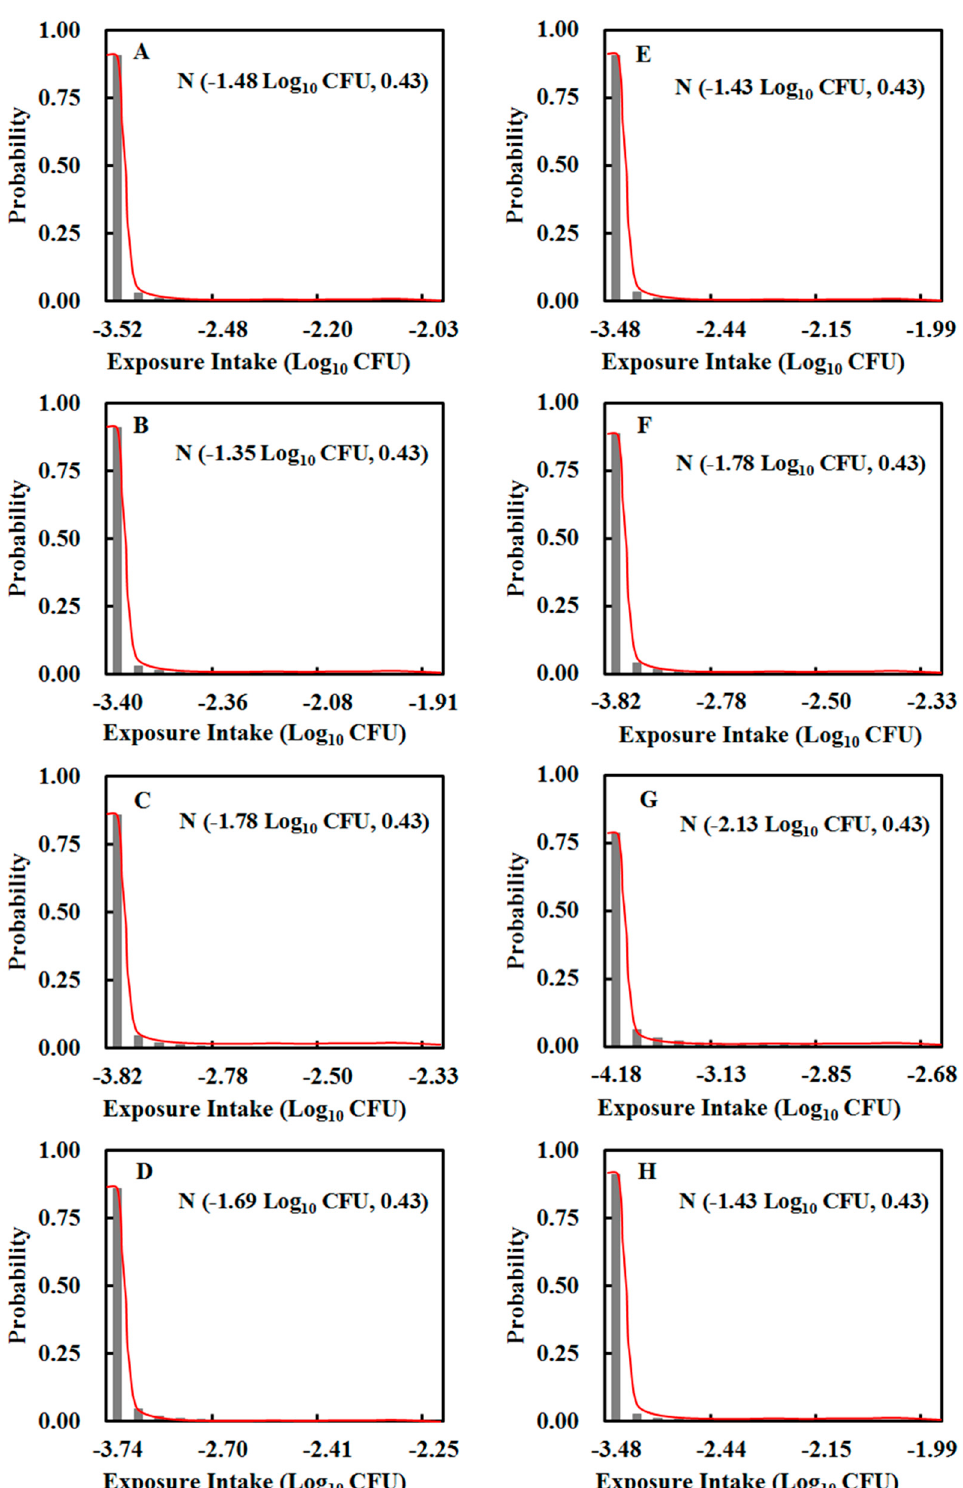
Figure A2. The probability distribution of ingesting E. coli O157:H7 among the Taiwanese population for each sex and age group from consuming medium beef imported from the USA. ( A ) Males and females aged 4-12 years, ( B ) males aged 13-18 years, ( C ) females aged 13-18 years, ( D ) males aged 19-65 years, ( E ) females aged 19-65 years, ( F ) males aged >65 years, ( G ) females aged >65 years, and ( H ) females aged 19-49 years (of childbearing age).